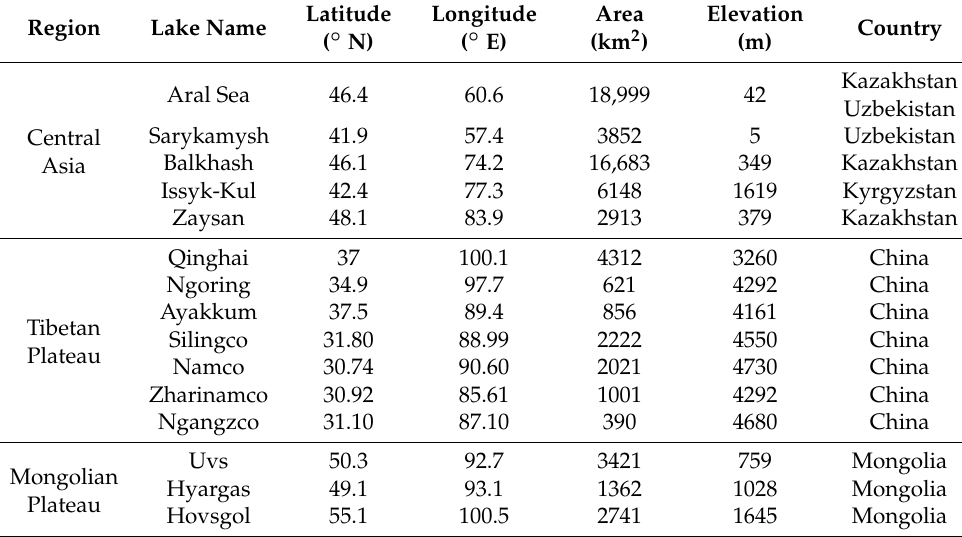
Table 1. Detailed information about the selected